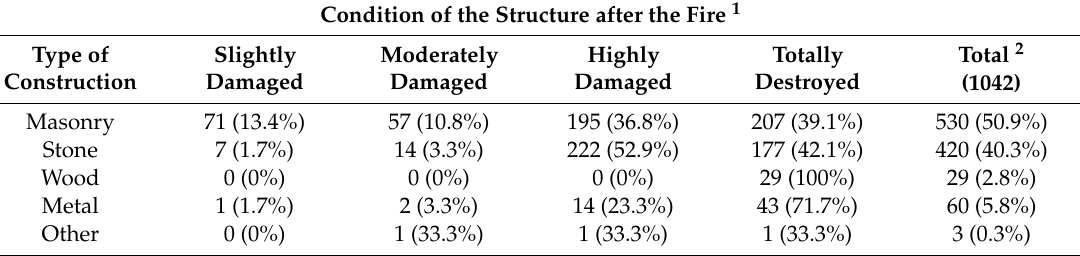
Table 6. Degree of damage according to the type of construction.